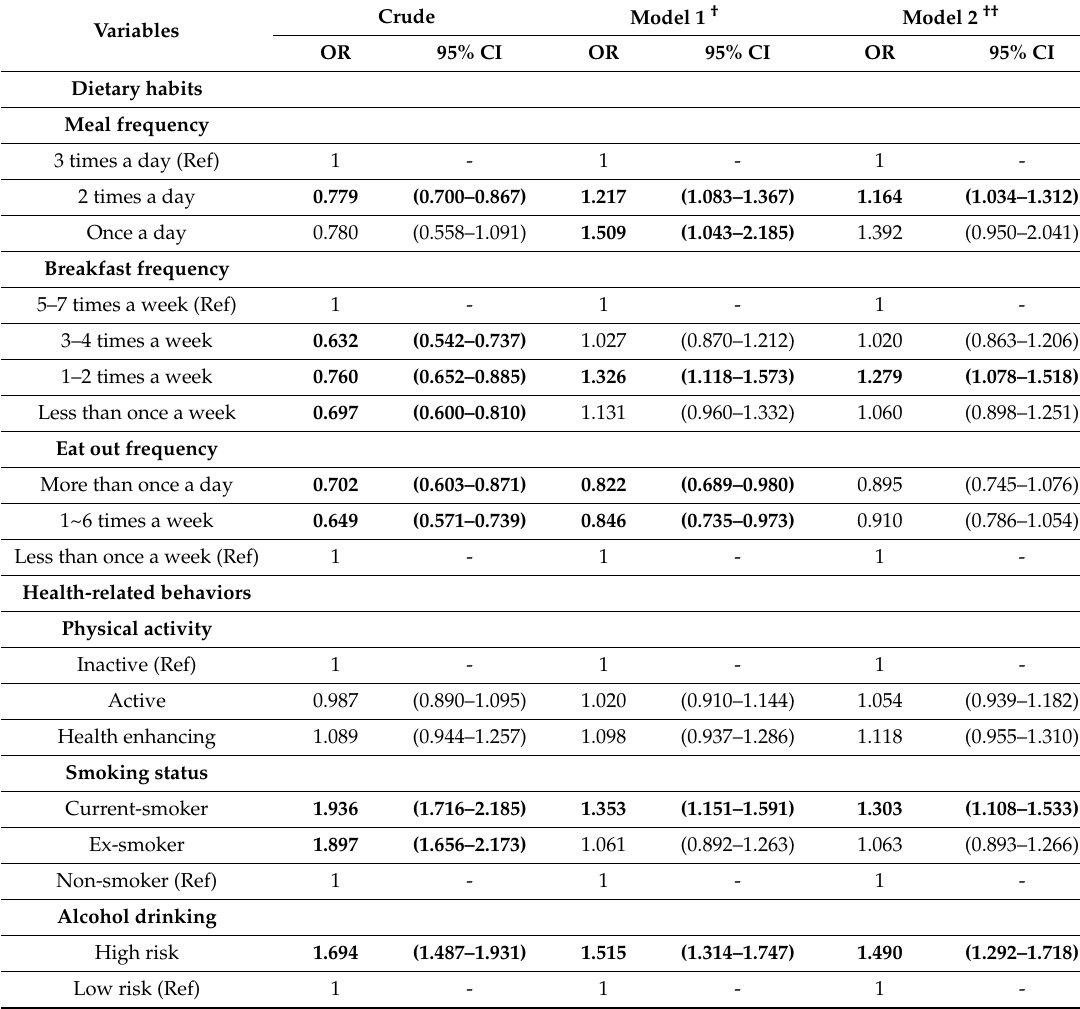
Table 4. Associations (ORs and 95% CIs) between health-related behaviors including dietary habits and CMP among adults aged from 19 to 64 years in South Korea (KNHANES 2013–2015)